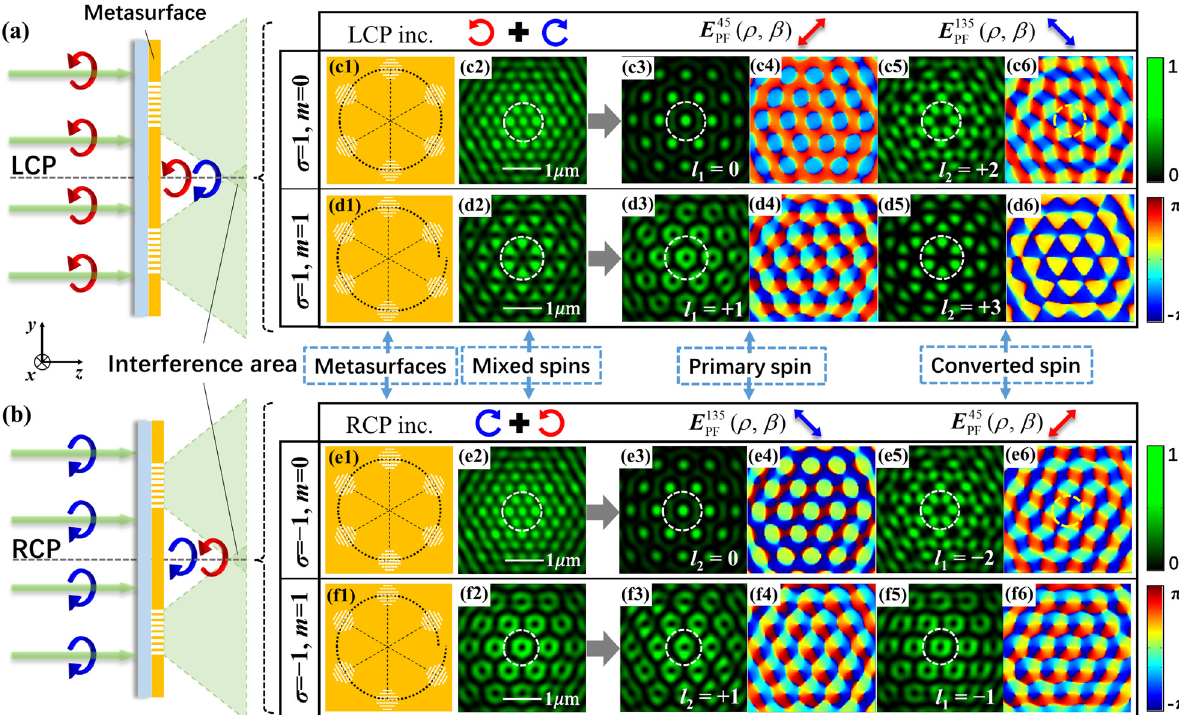
Figure 2: Simulation results of the dual-spin channel lattices induced by metasurfaces of samples A and B: (a) and (b) schematic of the generationoftheoverlappinglattice fi eldsundertheincidenceofLCPandRCP,respectively.(c1)and(e1)SketchmapofsampleA.(d1)and(f1) SketchmapofsampleB.(c2 – c6)and(d2 – d6)SimulatedresultsofsamplesAandB,respectively,illuminatedbyLCPlight.(e2 – e6)and(f2 – f6) Simulated results of samples A and B, respectively, illuminated by RCP